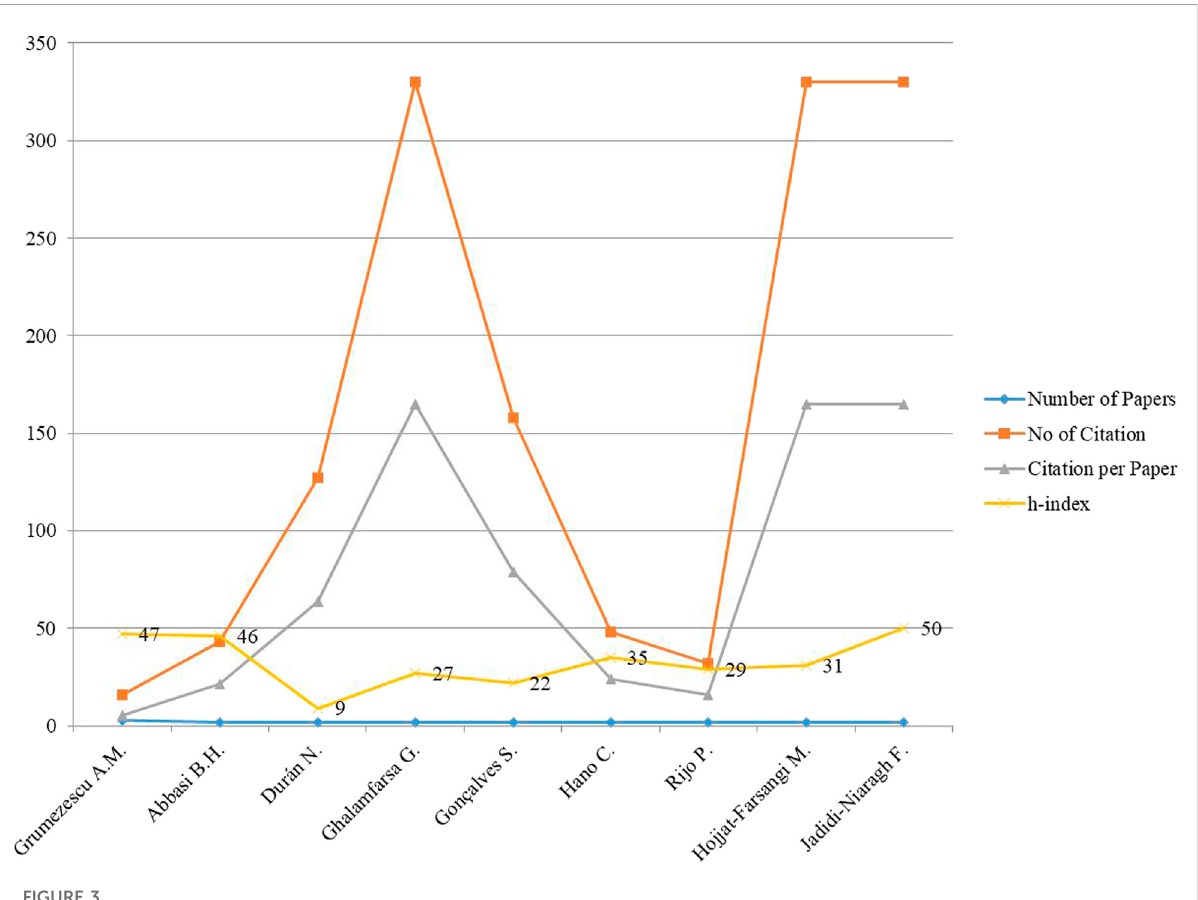
FIGURE 3 Author details in cancer therapy with